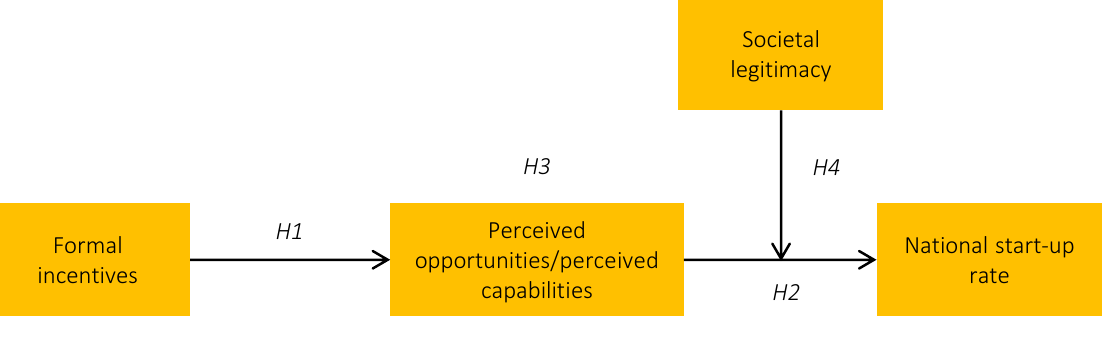
Figure 1. Conceptual framework